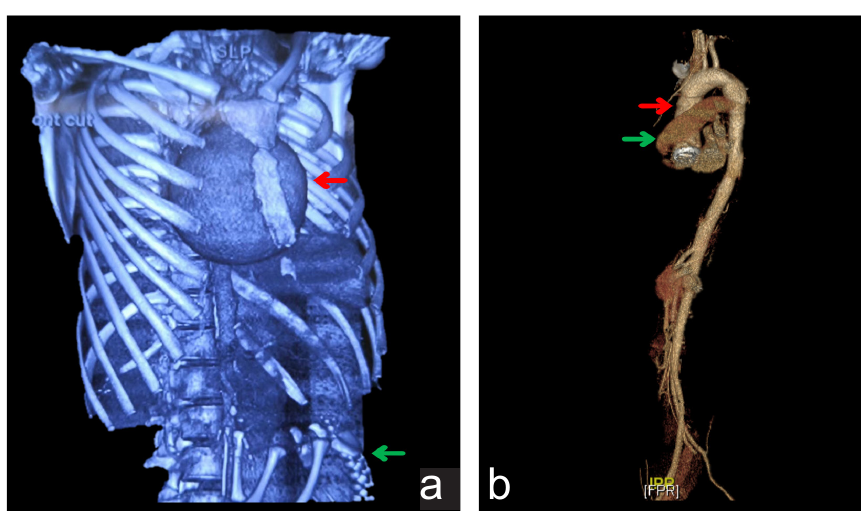
Fig. 3 - Changes in pre- and postoperative computed tomography angiography images of Case 3. (A) 3D reconstruction of preoperative CT images shows the location of the giant ascending aortic aneurysm marked by a red arrow and the fetal skeleton marked by a green arrow. (B) 3D reconstruction of postoperative CT images shows the artificial blood vessel marked by a red arrow and a circular low-density shadow marked by a green